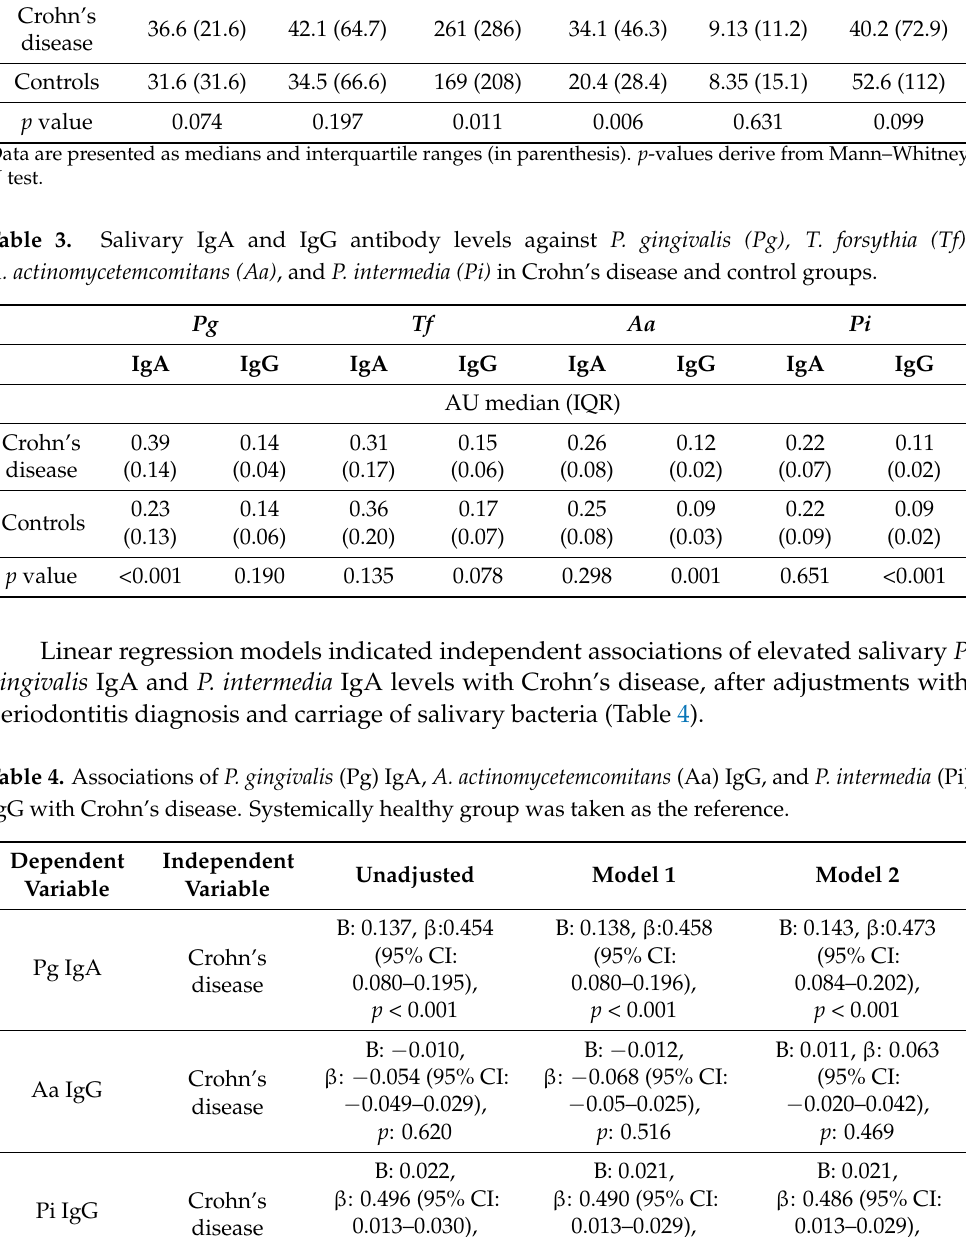
Table 2. Salivary levels of IgA, IgG1, IgG2, IgG3, IgG4, and IgM antibodies in Crohn’s disease and control groups.